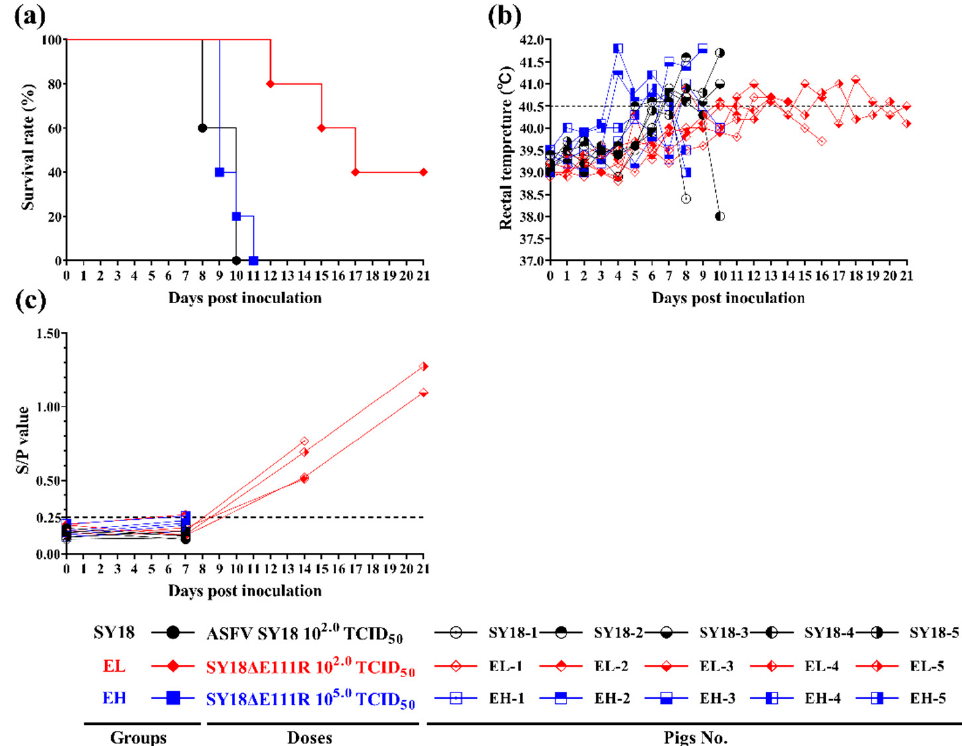
Figure 4. Results of survival rates, rectal temperature, and p54 antibody S/P values in pigs. ( a ) Sur- vival rates of pigs infected with ASFV SY18 and SY18 Δ E111R. ( b ) Rectal temperature data in pigs after infection. Each line represents the body temperature data of an individual animal. ( c ) The p54 antibody S/P values of animal sera. Values of S(OD 450 )/P(OD 450 ) greater than 0.25 for each group were considered positive. Table 2. Survival and fever responses of pigs infected with SY18 ∆ E111R and ASFV SY18.